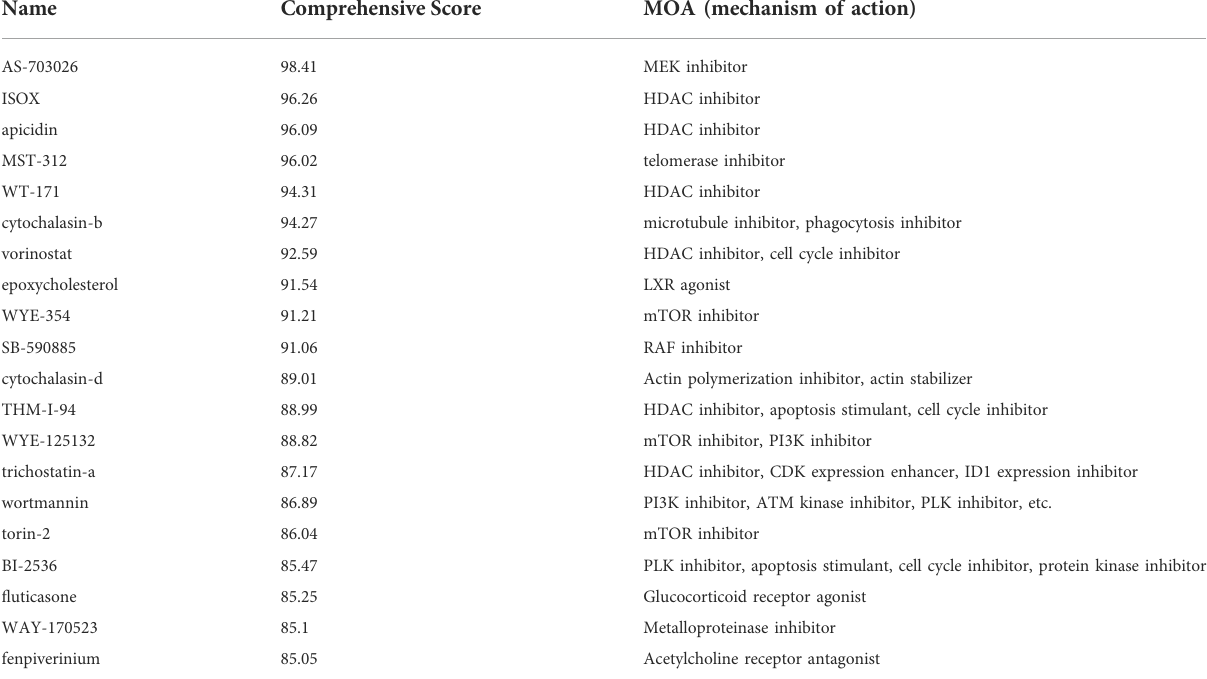
TABLE 1 Scores and mechanisms of 20 potential